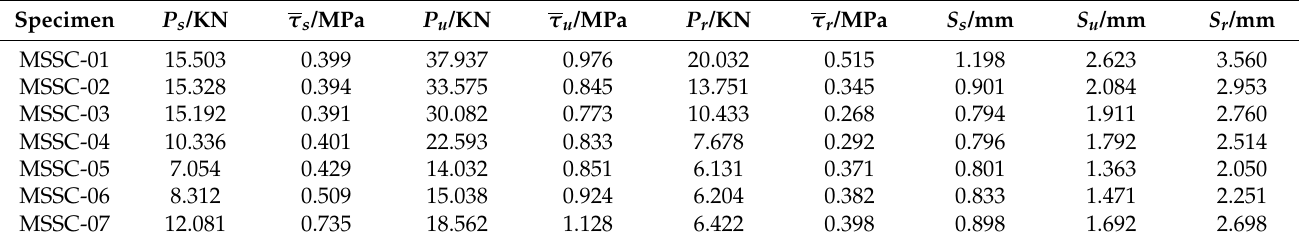
Table 4. List of feature point